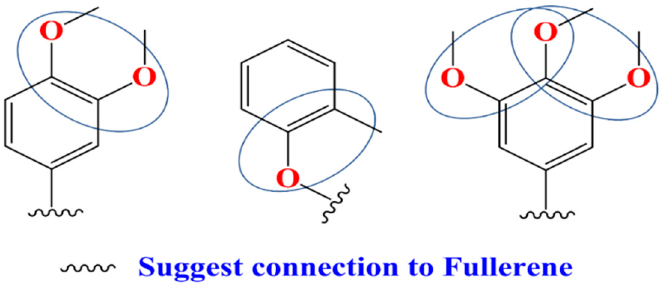
Figure 1. Fragments like -ortho directing groups substituted in the benzene ring help in power conversion e ffi ciency (PCE) increment.